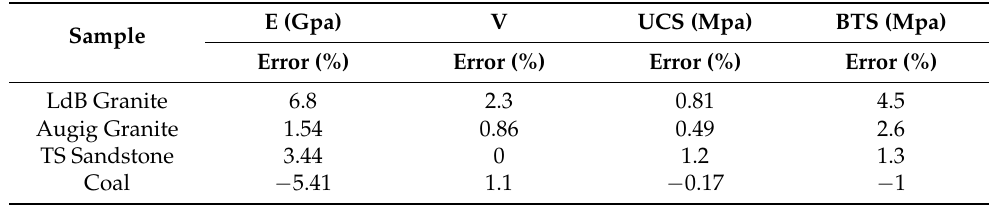
Table 4. Comparison between experiment and simulation error